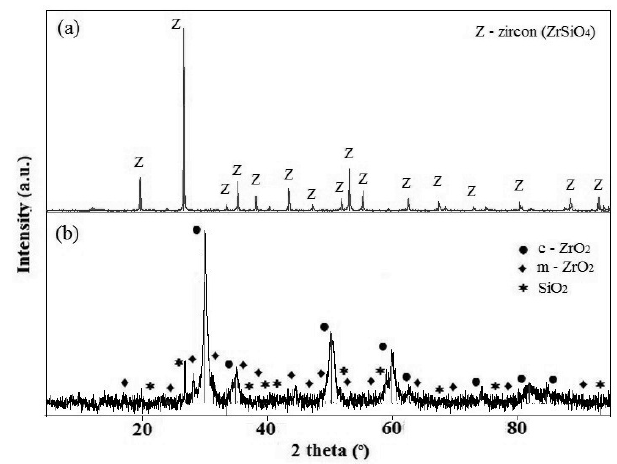
Coatings 2017 , 7 , 142